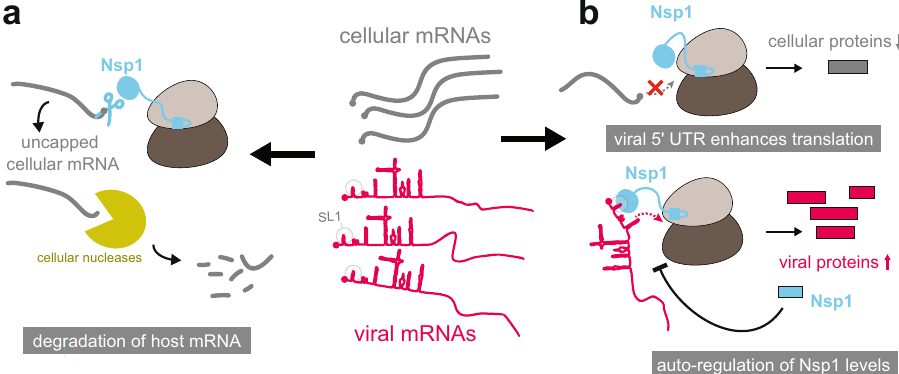
Fig. 2 Nsp1 impacts host gene expression by several mechanisms. Schematic representation of the main activities and mechanisms through which Nsp1 is thought to act in order to favour gene expression to viral transcripts, without shutting down mRNA translation completely. a Nsp1 may have a role in shifting the balance between viral and cellular RNAs in its favour, by inducing the cleavage/decapping of host mRNAs, which leads to their degradation by cellular nucleases. b The viral 5 ′ UTR (and in particular stem loop SL1) is likely a critical factor in directing ribosomes to the viral transcripts and overriding the translation block. Moreover, it has also been proposed that through Nsp1 autoregulation a total block of host mRNA translation may be